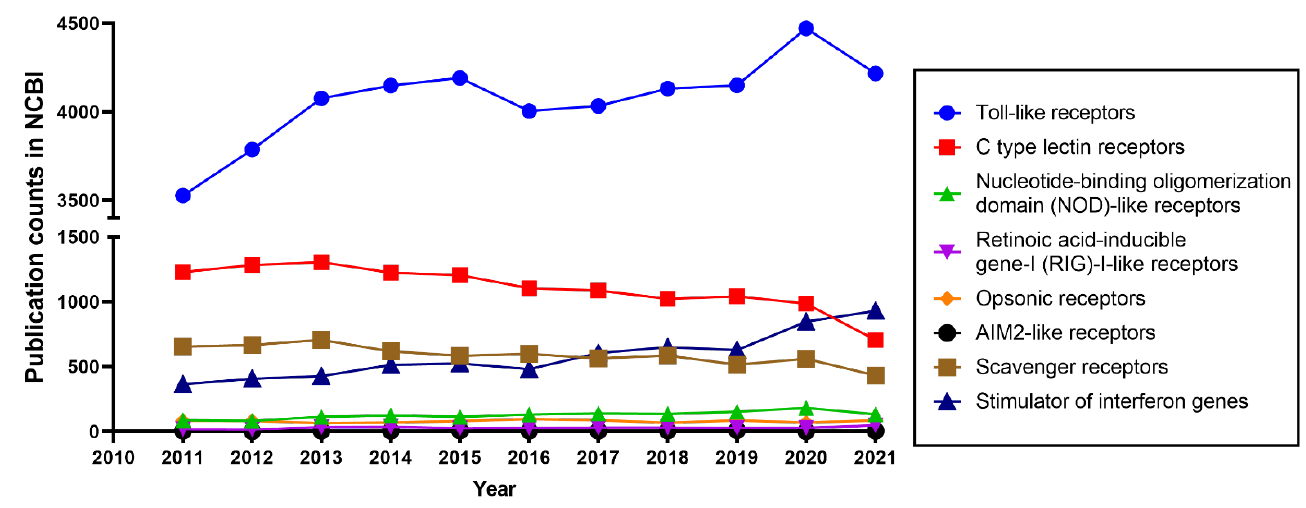
Figure 1. Publication counts for eight PRRs in the PubMed database (National Library of Medicine, National Center for Biotechnology Information, Bethesda, MD, USA). The full name of the eight PRRs was used as a keyword in PubMed. Access to Pubmed is through the link: https://pubmed.ncbi.nlm. nih.gov/. The results of the publication counts are sorted and exported by “Year”. The publication counts from the last 10 years (from 2011–2021) of 8 PRRs are shown in this Figure.